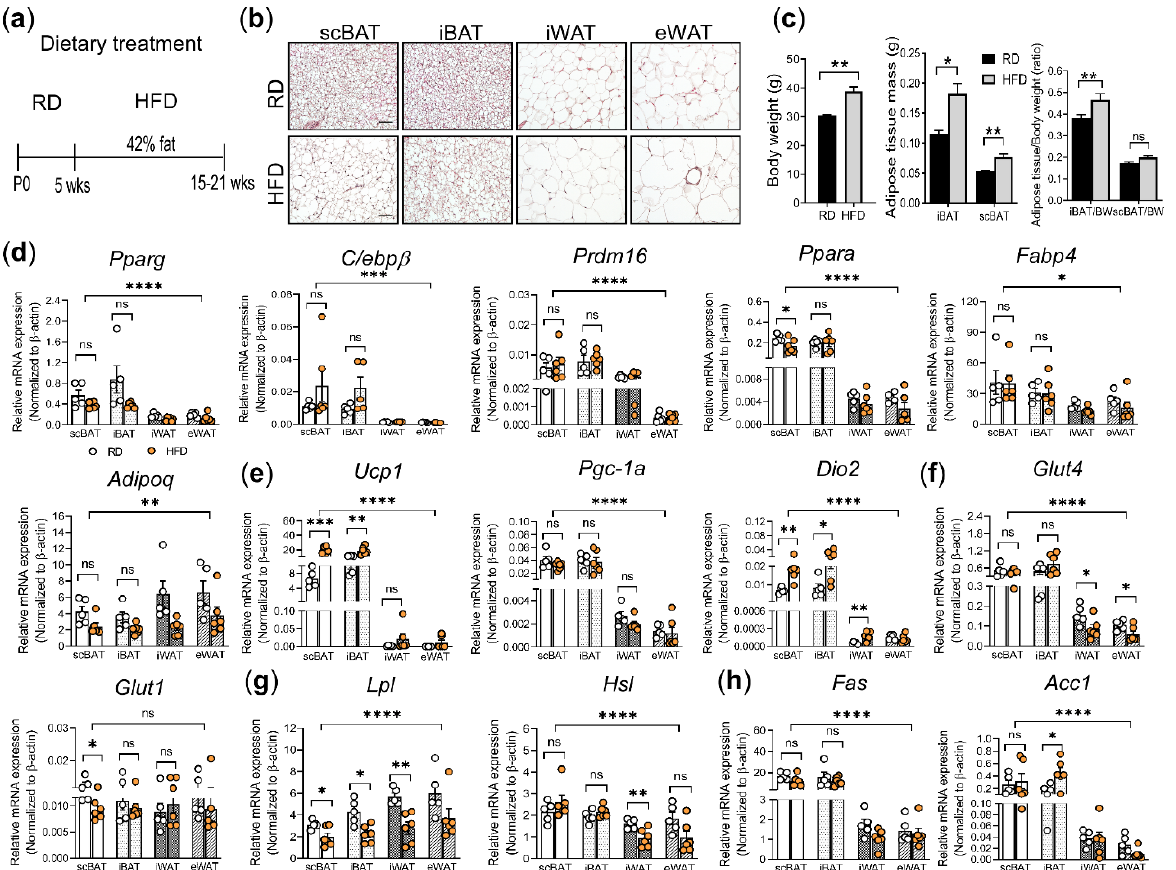
Figure 2. The effect of HFD on the adipocyte morphology and gene expression in scBAT, iBAT, iWAT, and eWAT. ( a ) Schematic diagram of the HFD study design. P0: postnatal day 0, wks: weeks. Mice were subjected to 10 to 16 weeks of RD or HFD. ( b ) Representative images of H&E-stained sections of scBAT, iBAT, iWAT, and eWAT from mice treated with RD or HFD for 16 weeks. n = 3–4. Scale bar = 50 µm. ( c ) Body weight (BW), adipose tissue mass, and ratio of adipose tissue to body weight of mice described in ( b ) (RD, n = 4 and HFD, n = 4). ( d – h ) RT-qPCR analysis of adipocyte differentiation marker genes, thermogenic genes, glucose uptake genes, and lipid processing genes in scBAT, iBAT, iWAT, and eWAT depots from mice fed 10 weeks with RD or 10 weeks with HFD. ( d ) Adipocyte differentiation markers, Pparg , C/ebpβ , Prdm16 , Pparα , Fabp4 , and Adipoq . ( e ) Thermogenic genes, Ucp1 , Pgc-1α , and Dio2 . ( f ) Glucose transporters, Glut4 and Glut1 . ( g ) Lipid uptake and processing genes, Lpl and Hsl . ( h ) Lipogenesis genes, Fas and Acc1 . Data are presented as mean ± SEM. The expression of these genes is normalized to the housekeeping gene β-actin. n = 5–6 for each group. * p < 0.05, ** p < 0.01, *** p < 0.001, **** p < 0.0001, ns = nonsignificant.